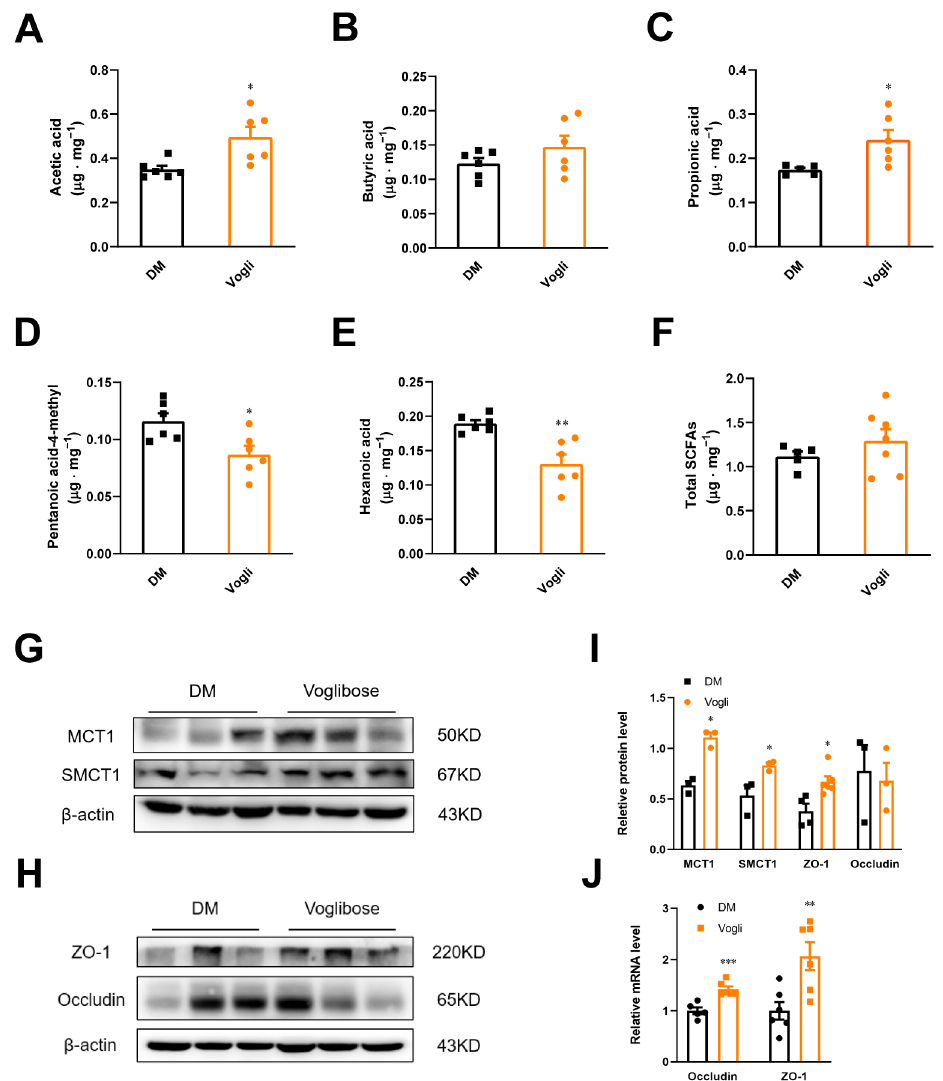
Figure 2. Voglibose alters the composition and transport of SCFAs in KKAy mice. Fecal SCFA concentra-tions including ( A ) acetic acid, ( B ) butyric acid, ( C ) propionic acid, ( D ) pentanoic acid-4-methyl, ( E ) hexanoic acid and ( F ) total SCFAs were quantified. Data are expressed as the mean ± SEM, n = 5–6. ( G ) MCT1, SMCT1, ( H ) ZO-1 and occludin protein abundance in the ileum tissue. ( I ) Quantification of proteins in ( G , H ). ( J ) Quantitative PCR analysis of occludin and ZO-1. Data are expressed as the mean ± SEM and individual data was shown in square (DM) and circle (Vogli), n = 3–6. * p < 0.05, ** p < 0.01, *** p < 0.001. DM, diabetic model group; Vogli, voglibose-treated